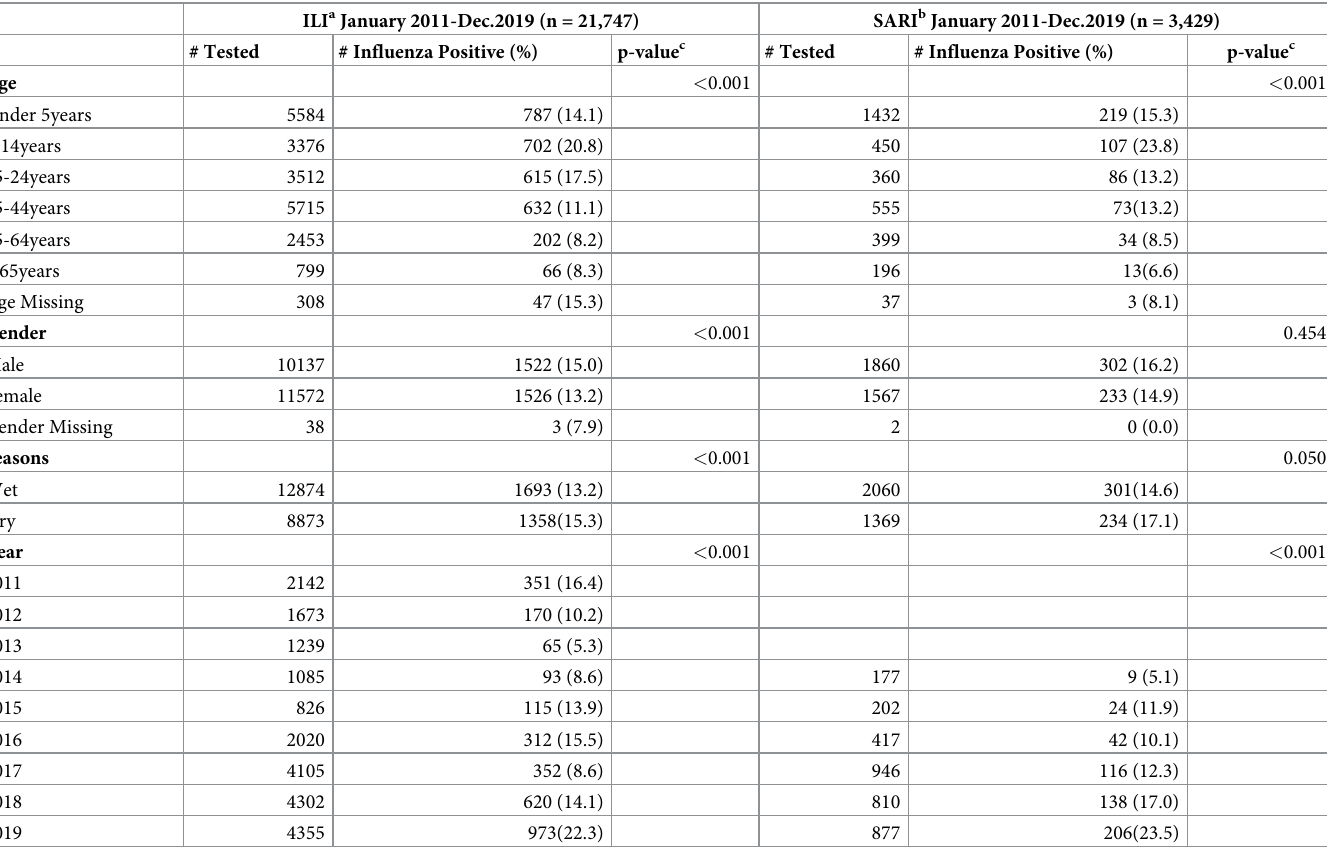
Table 1. Demographic characteristics of influenza-like illness (ILI) and severe acute respiratory illness (SARI) cases in Ghana from 2011 to 2019. ILI a January 2011-Dec.2019 (n =